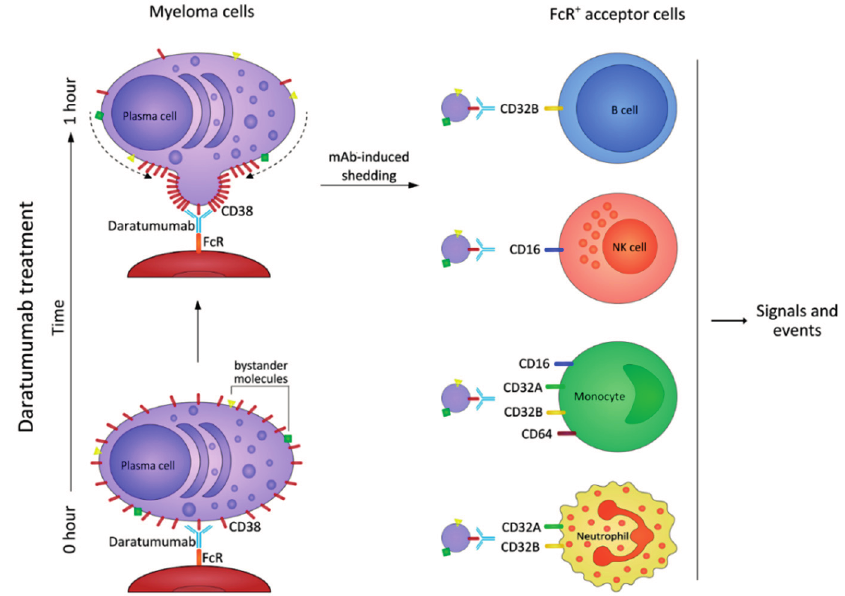
Figure 7. Events marking the interactions occurring in vivo after DARA treatment. Some steps are